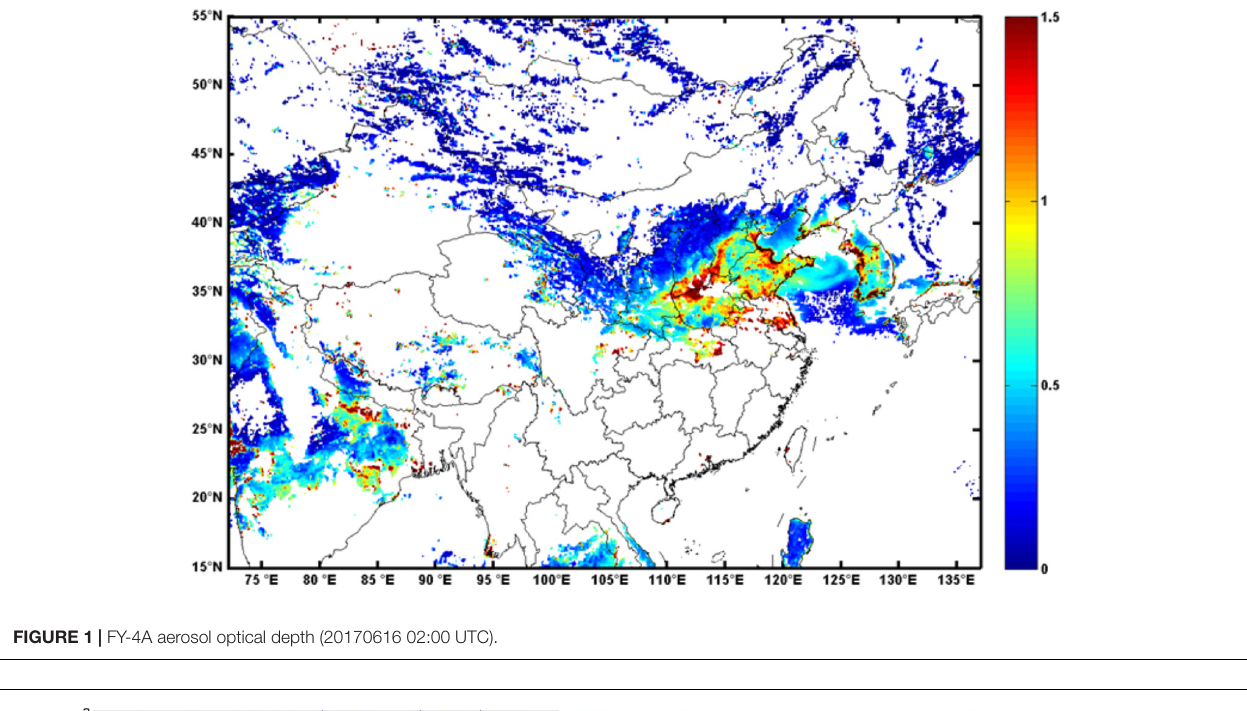
FIGURE 1 | FY-4A aerosol optical depth (20170616 02:00 UTC).